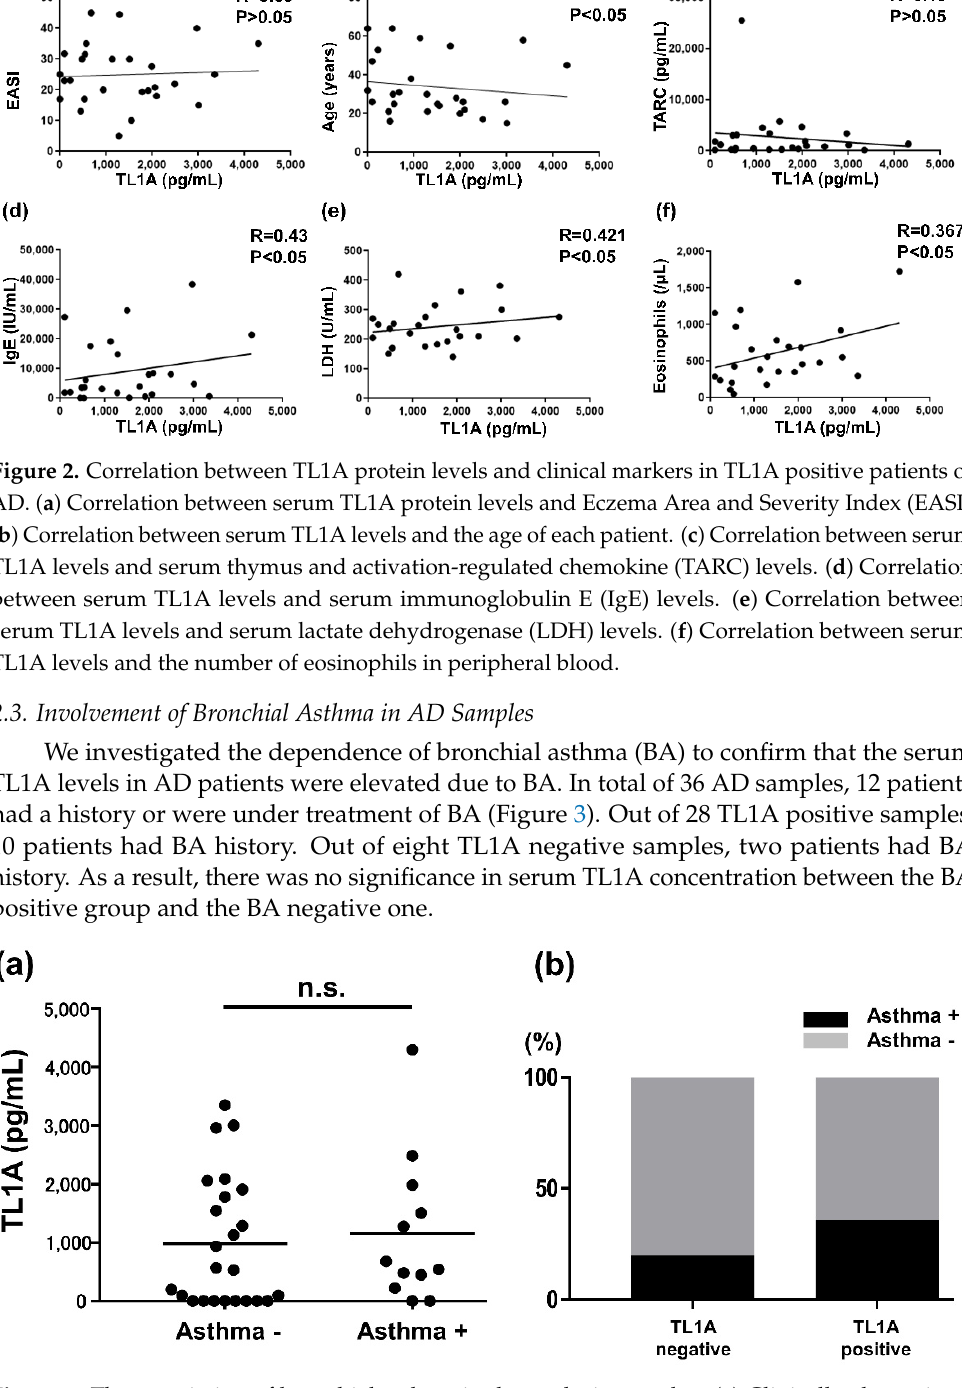
Figure 3. The association of bronchial asthma in the analysis samples. ( a ) Clinically, the patients were divided into two groups: those with asthma or with pre-existing asthma (asthma + ) and those without pre-existing or comorbid asthma (asthma-). ( b ) Whether each sample corresponds to Asthma+ or Asthma- group was analyzed in TL1A positive and negative group respectively.